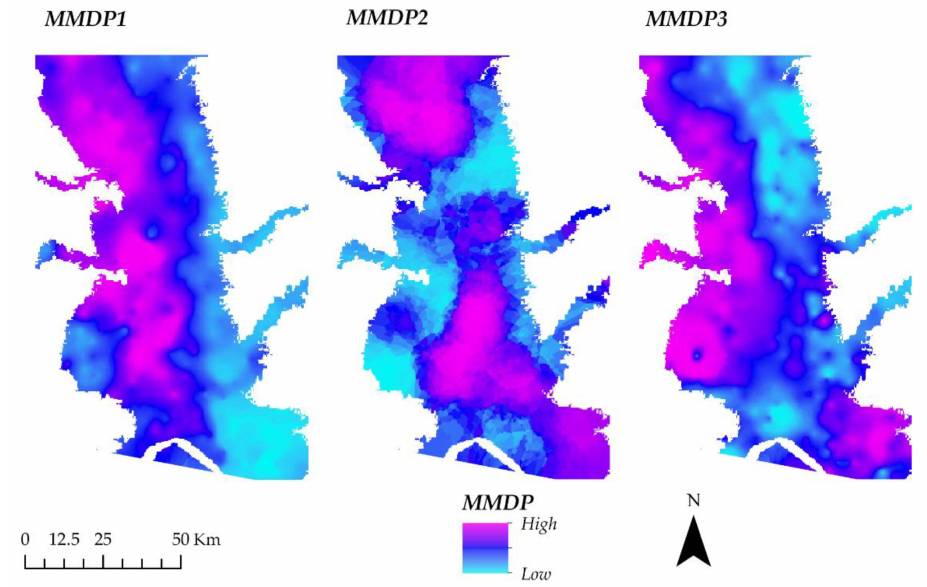
Figure 5. The three resulting multi-metal distribution patterns describe the generalized metal accu- mulation in the Sacramento River floodplain.